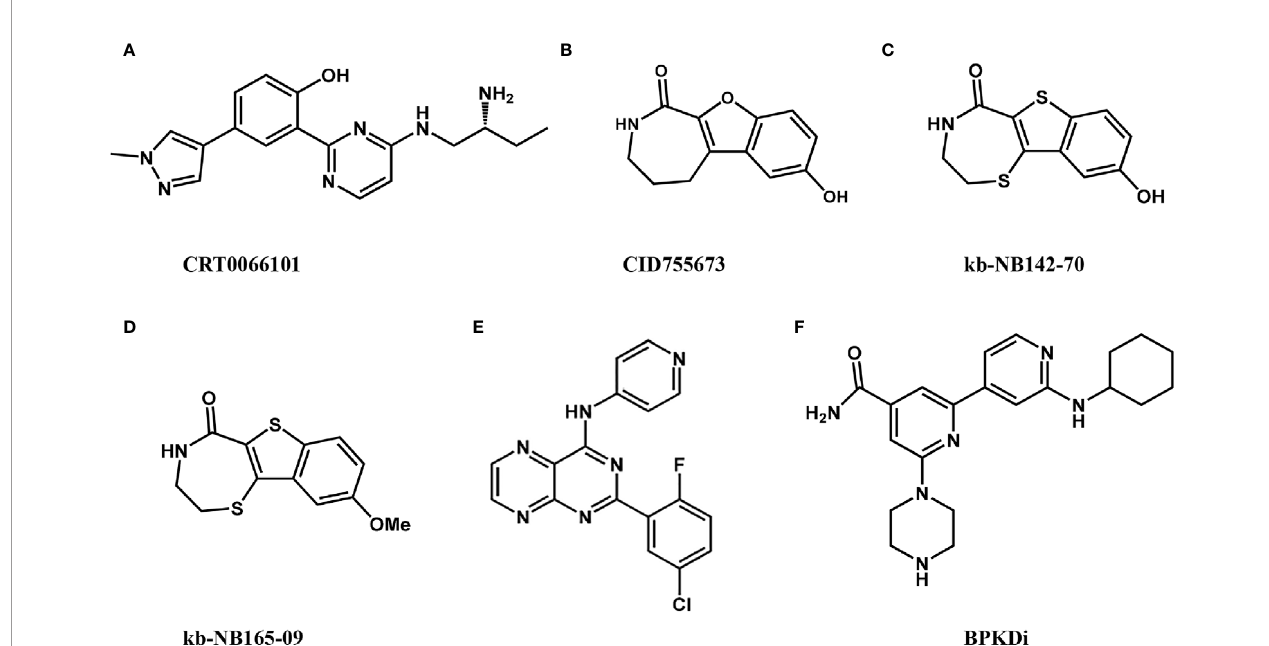
FIGURE 2 | Reported PKD